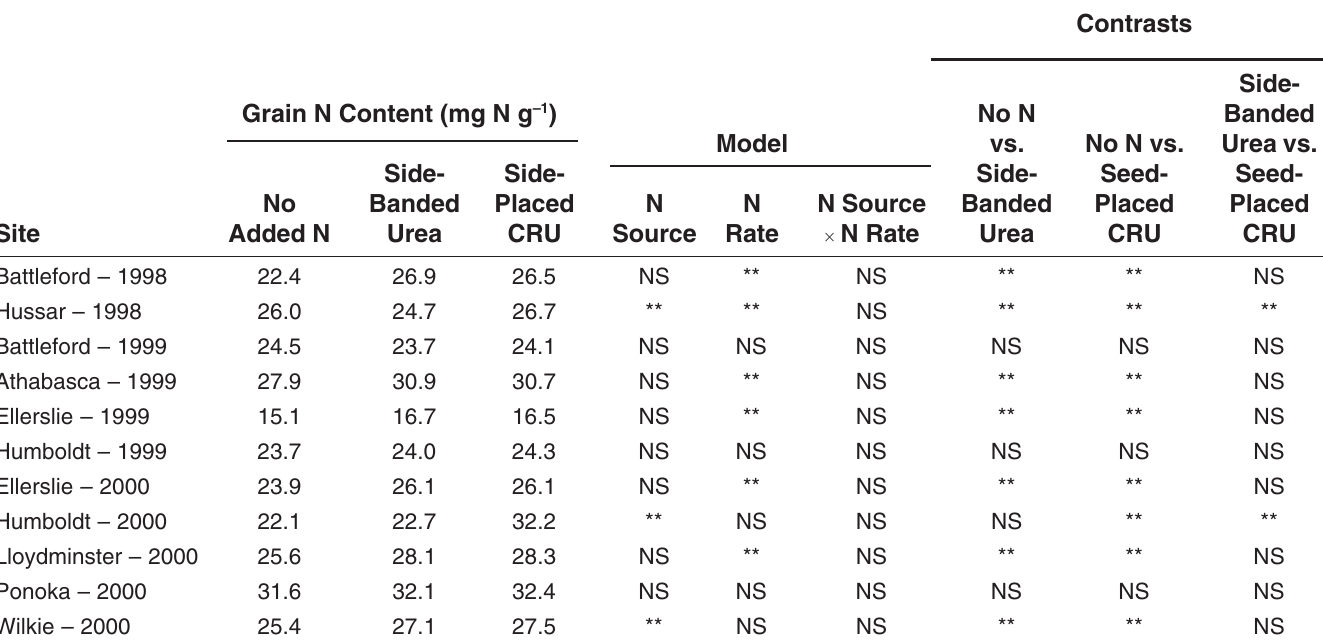
Means of Grain N Content at 11 Sites from 1998 to 2000